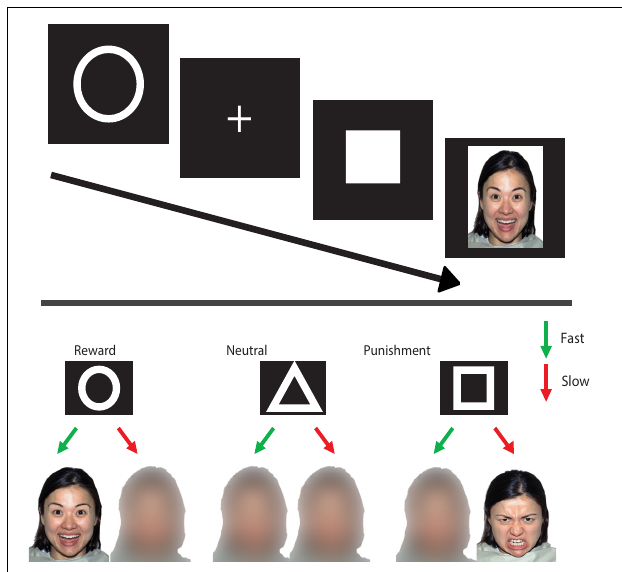
FIGURE 1 | Social incentive delay task. Upper panel: on each trial, a cue of (500ms) (indicating the condition) is followed by a delay period (1500–3500ms) after which a target is presented (150–500ms). When the target is shown, participants are instructed to press a button as fast as possible. Depending on whether the reaction time is fast enough, one of two possible feedback screens appear (1650ms). Lower panel: the different conditions with the associated feedback